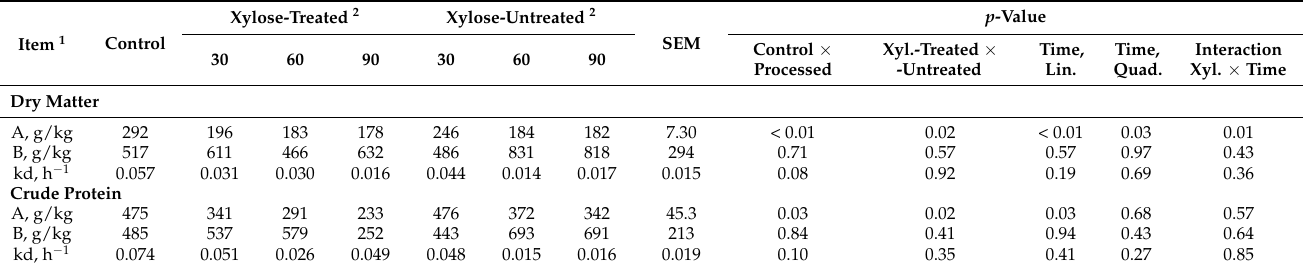
Table 5. Effects of conventional-oven heating and xylose inclusion on rumen degradation parameters of cottonseed meal.